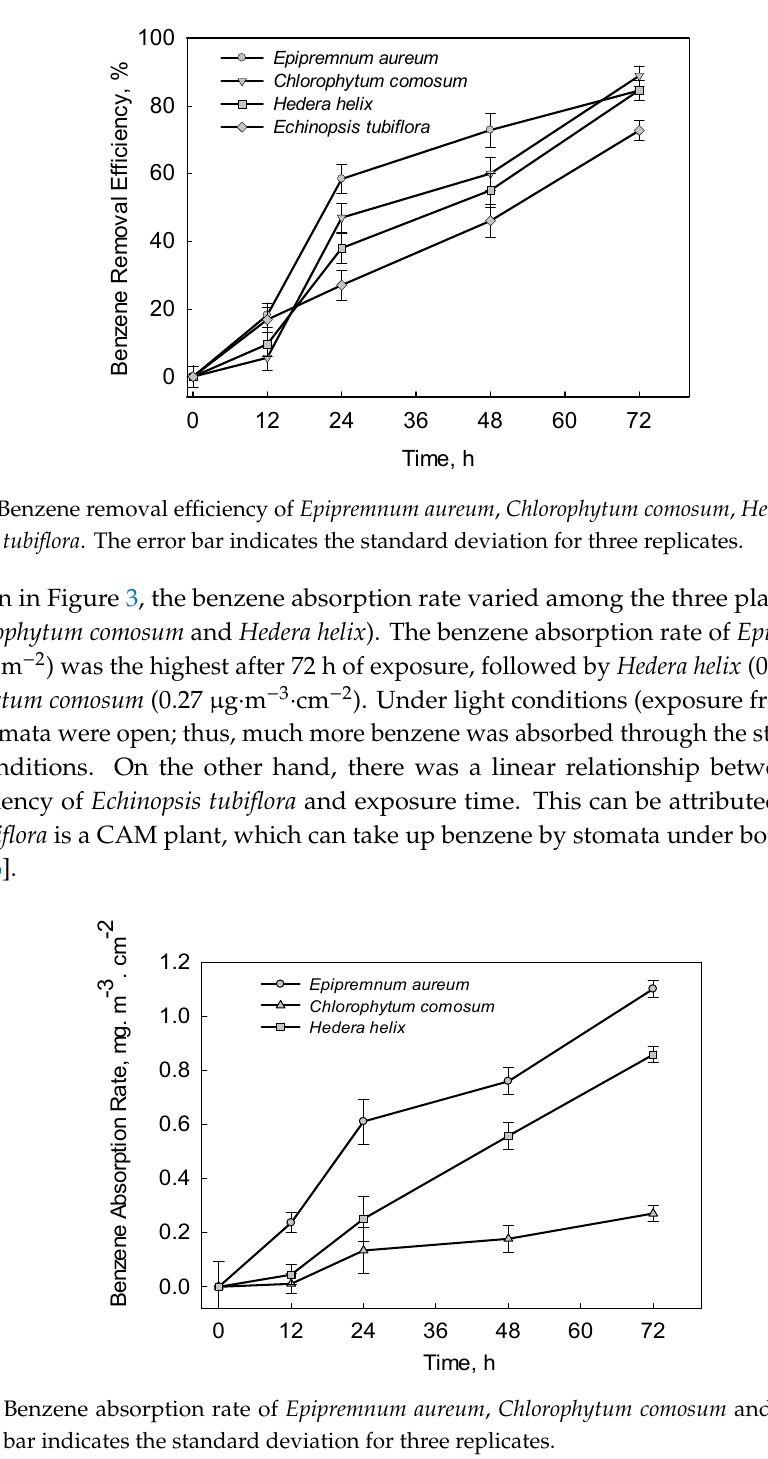
(b) Figure 1. Benzene removal efficiency of Epipremnum aureum in house ( a ) and in chamber ( b ). The error bar indicates the standard deviation for three replicates. Ornamental potted plants ( Epipremnum aureum ) were placed in the renovated house and chamber to remove benzene. As shown in Figure 1a, the decreasing trend of benzene concentration